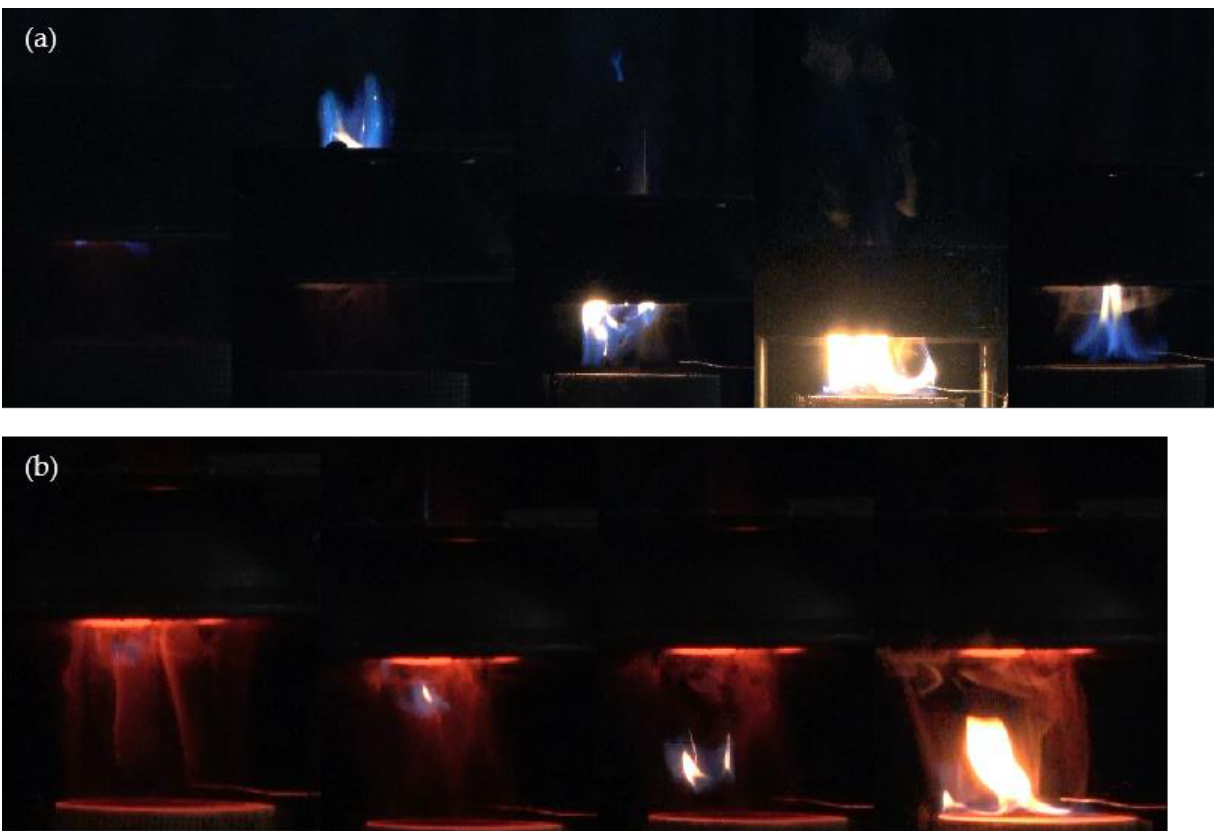
Figure 6. Timelapse images of ignition phenomena of pine wood: ( a ) D = 45 mm; ( b ) D = 80 mm. Figure 7 is the comparison of the MLR of pine wood at different radiant distances under low heat flow (25 kw/m 2 ). When D < 40 mm, pine wood cannot be ignited. The rise in the mass flux curve is mainly due to the evaporation of water. When 45 mm ≤ D ≤ 60 mm, the curves trend are similar. There are three peak in the curves. When D = 45 mm, under the action of the applied radiant heat flow, the outer layer of moisture evaporated and MLR reaches the first peak. Then, volatilization occurs on the pine wood and the MLR curve increases sharply. Autoignition occurs during the rising period of the MLR curve. This process lasts about 108 s. After the flaming combustion, the mass loss flux of the pine wood increased. Due to the combustion of volatile compounds and the effect of thermal feedback, the mass loss flux of the wood quickly reached a peak of 11 g/m 2 /s. At this time, the outer layer of the wood formed a certain thickness of the carbon layer, which prevented the rapid transfer of heat to the interior of the wood, and the temperature rise in the inner layer began to slow down, and the mass loss flux also began to drop sharply. Until about 150